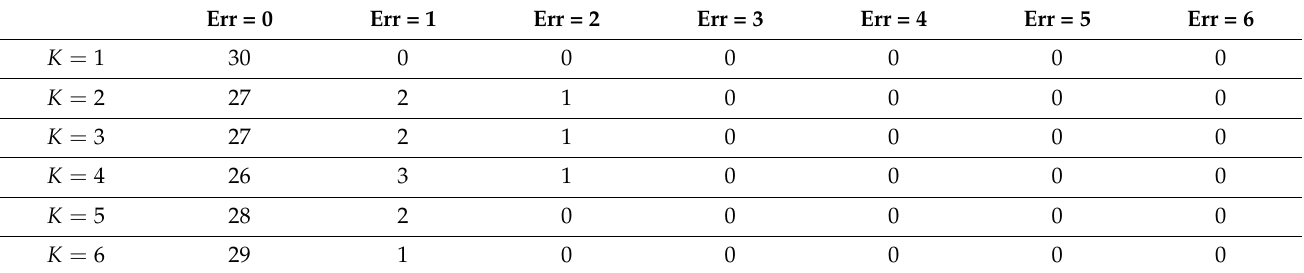
Table 7. Results of the matching accuracy of token-opinion